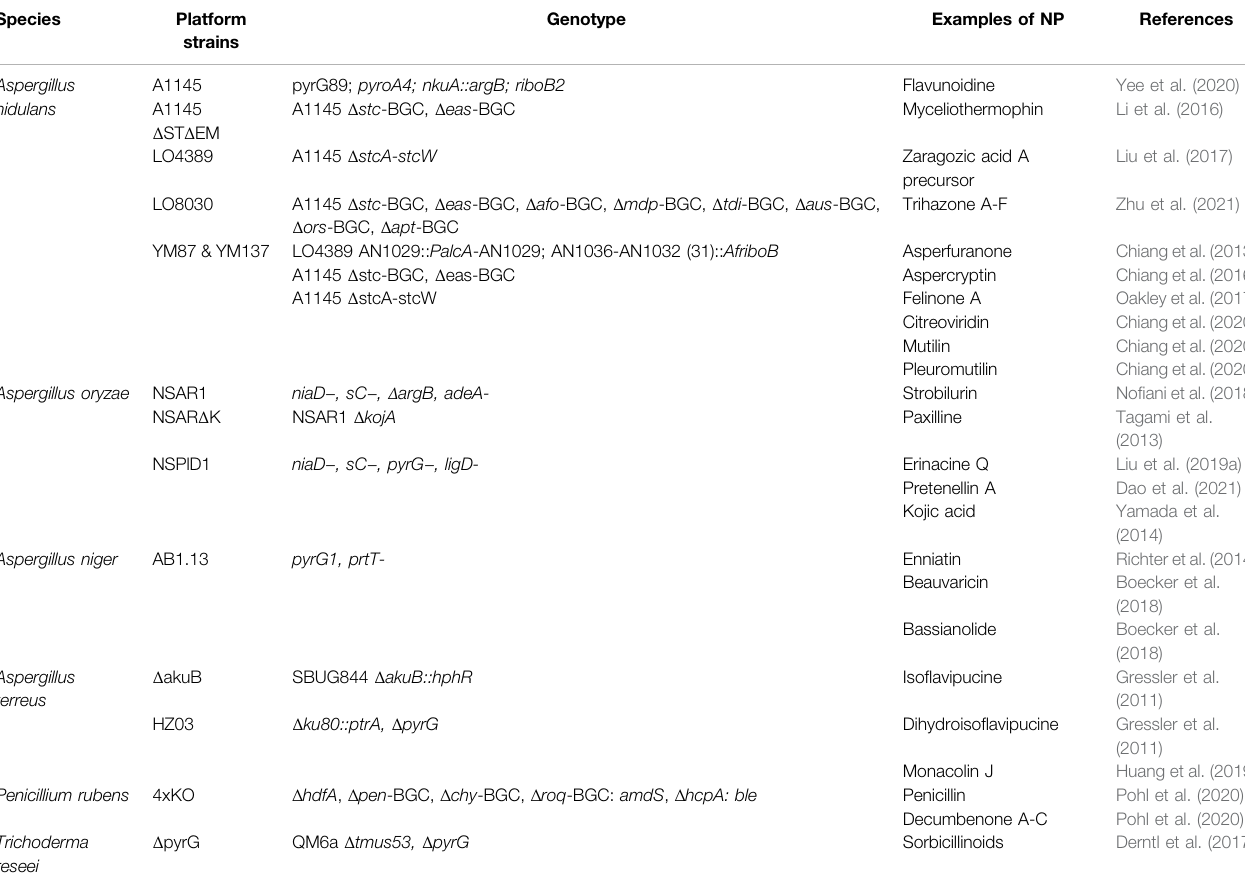
TABLE 1 | Examples of fungal expression platforms for the production of natural products and the characterization of biosynthetic gene clusters.